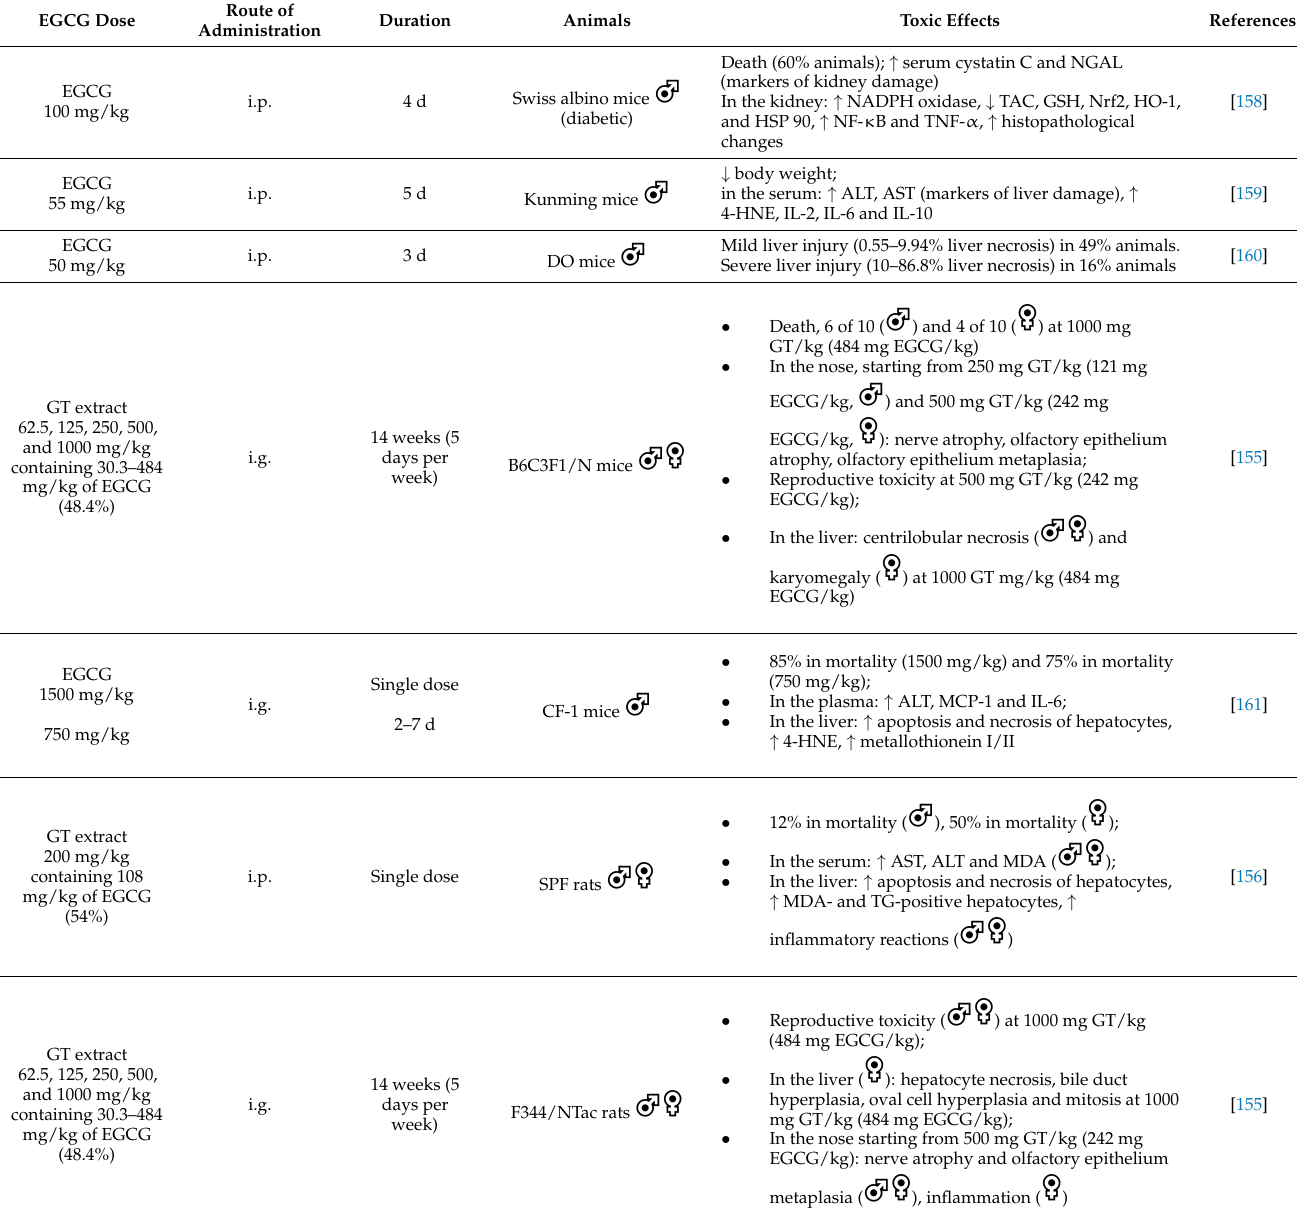
Table 4. Selected literature data on the toxic effects of EGCG and EGCG-containing green tea extracts or preparations in